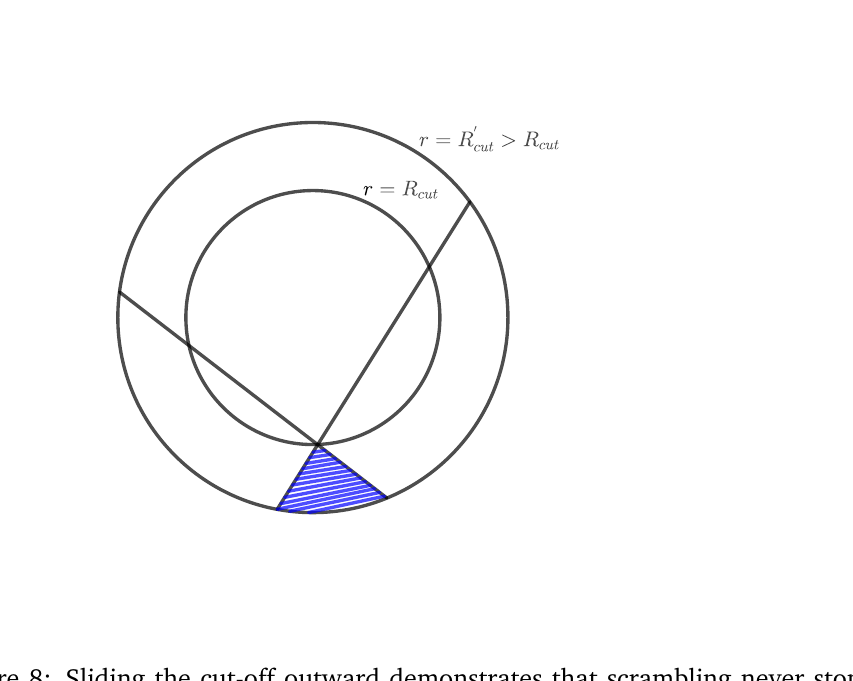
Figure 8: Sliding the cut-off outward demonstrates that scrambling never stops in flat